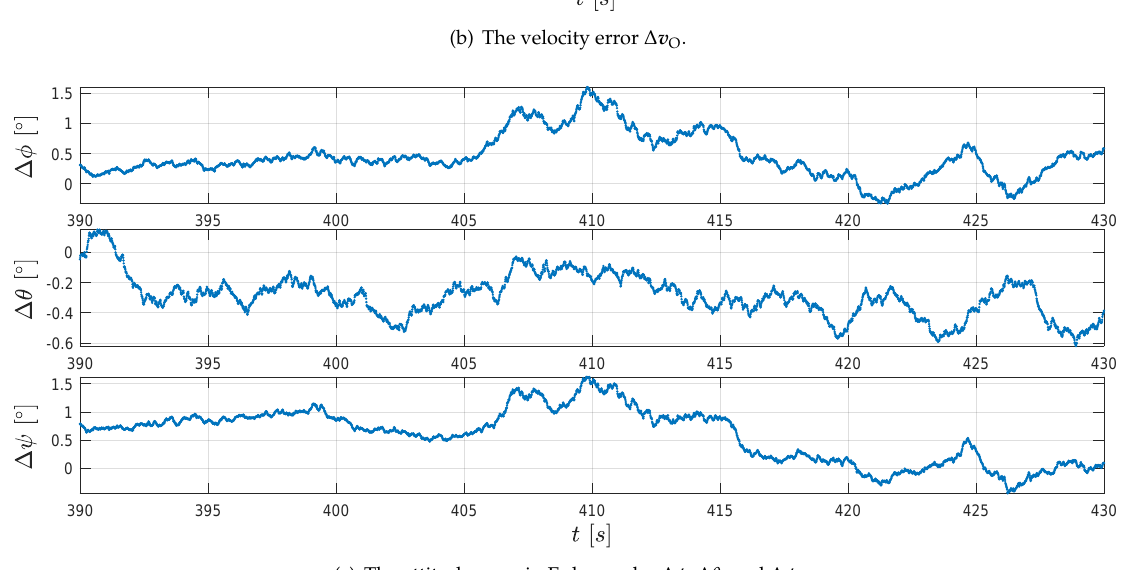
(c) The attitude error in Euler angles ∆ φ , ∆ θ , and ∆ ψ . Figure 6. The RTS smoother estimation error for the generated reference